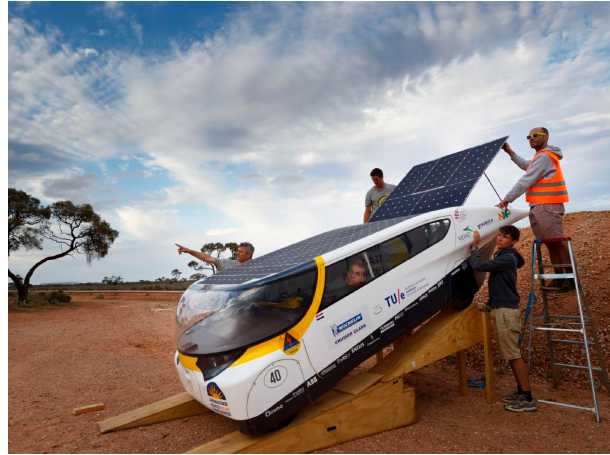
Figure 11. The Stella, winner of the Solar Challenge. Reproduced with permission from [32].